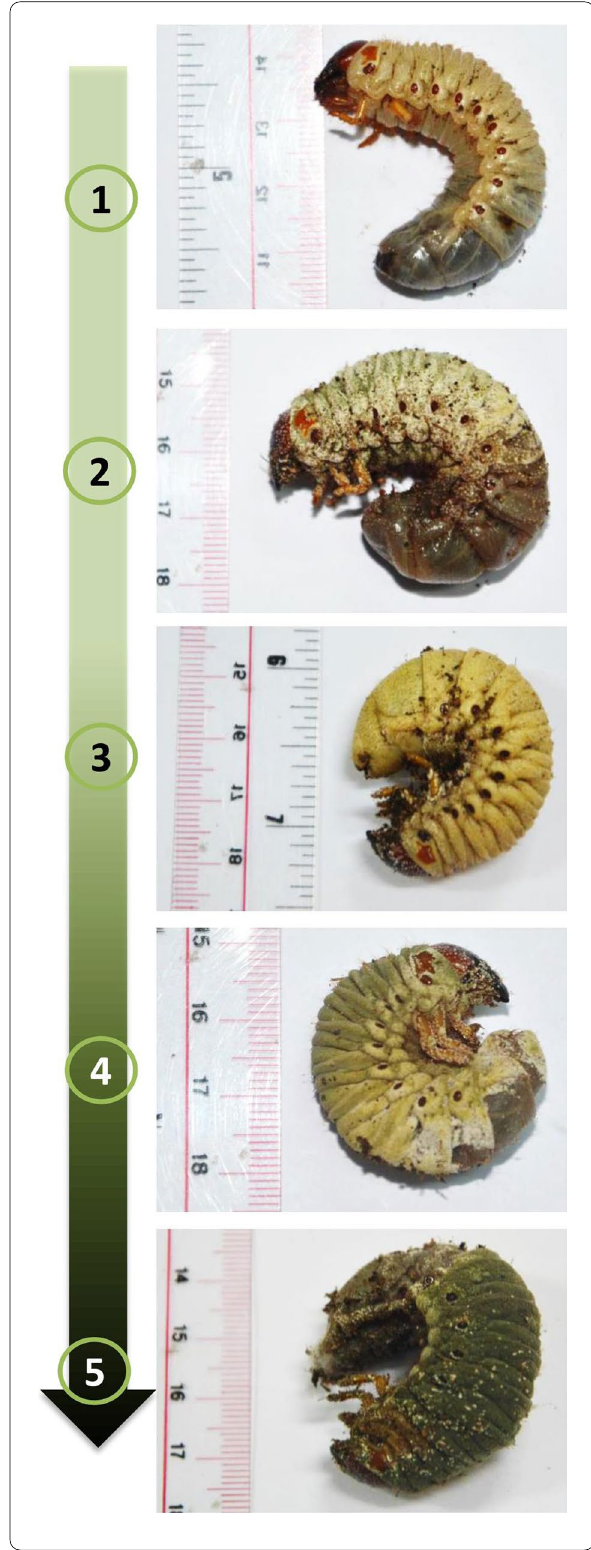
Fig. 5 Stages of Oryctes rhinoceros larvae infected by Metarhizium. (1) Healthy larvae, (2) 2 days after dead, whitish growth of conidia on larvae, (3) conidia sporulation were covering the whole of larvae after 4 days of dead, (4) in the next stage, the appearance of conidia becomes greenish after 5 days of dead, (5) the green conidia were covering the whole of larval cadavers after 7 days of dead